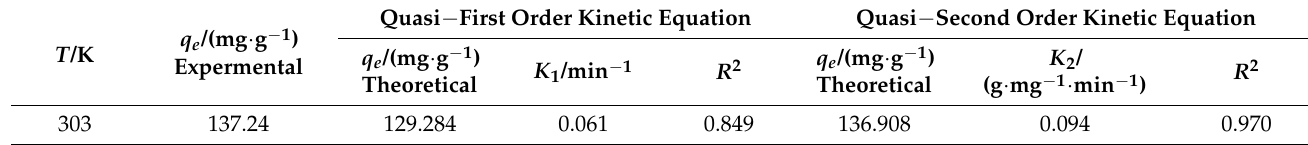
Table 1. Correlation coefficient of kinetic